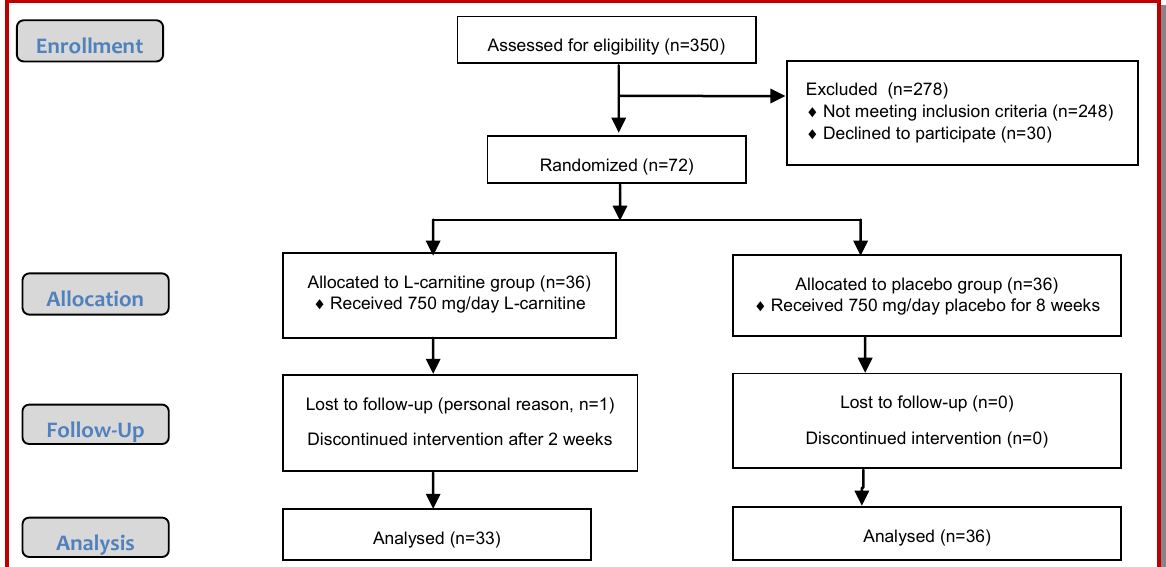
Figure 1: Study flow